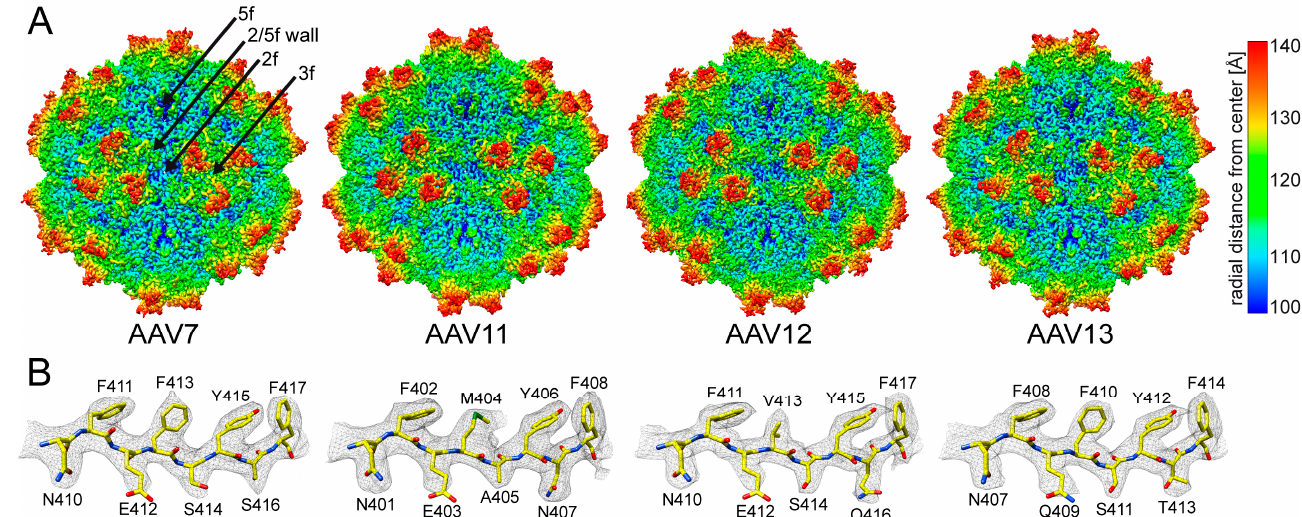
Figure 2. The AAV7 and AAV11–13 capsid structures. ( A ) The capsid surface density maps contoured at a sigma ( σ ) threshold level of 2.0. The maps are radially colored (blue to red) according to distance to the capsid center, as indicated by the scale bar on the right. The icosahedral 2-, 3-, and 5-fold axes as well as the 2/5-fold wall are indicated on the AAV7 capsid map. ( B ) The AAV7 and AAV11–13 amino acids modeled for the β G strand are shown inside their respective density maps (black mesh). The amino acid residues are as labeled and shown in stick representation and colored according to atom type: C = yellow, O = red, N = blue, S = green. This figure was generated using UCSF-Chimera [48].